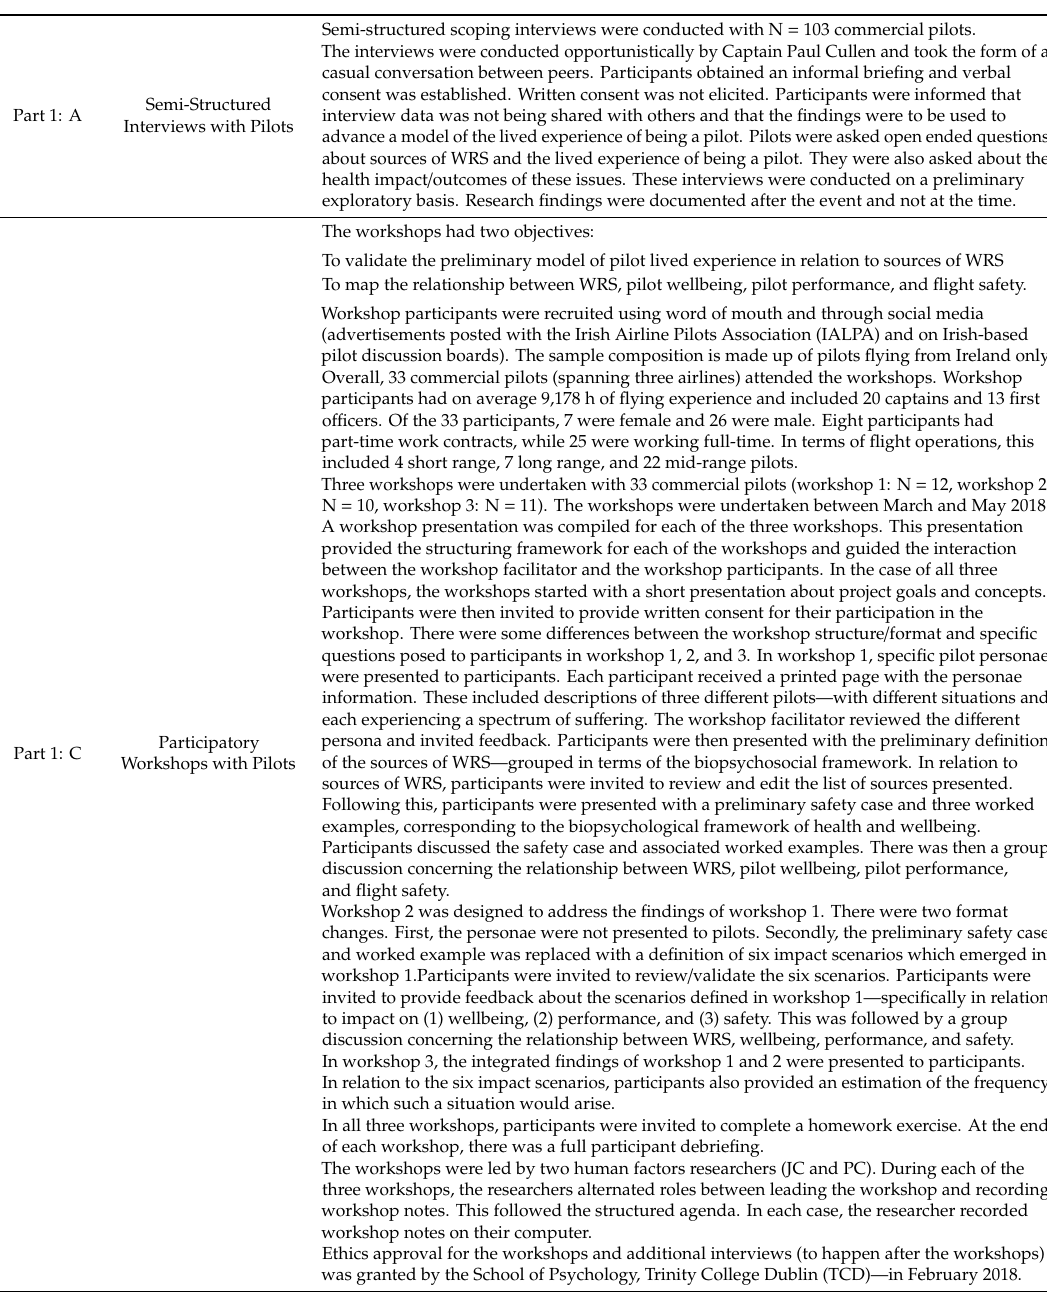
Table A1. Field Research & Data Analysis